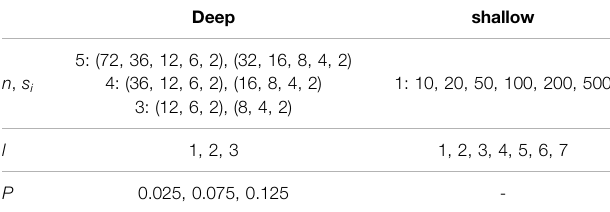
TABLE 1 | Hyperparameters for deep and shallow networks. Deep